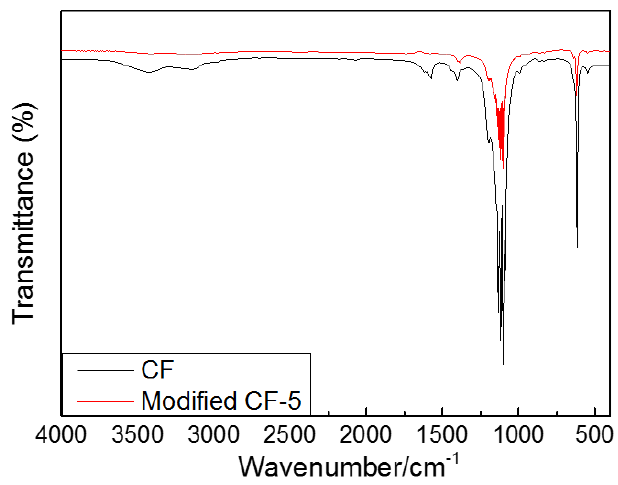
Figure 1. Comparison of FT-IR spectra of pristine CF and modified mCF-5.